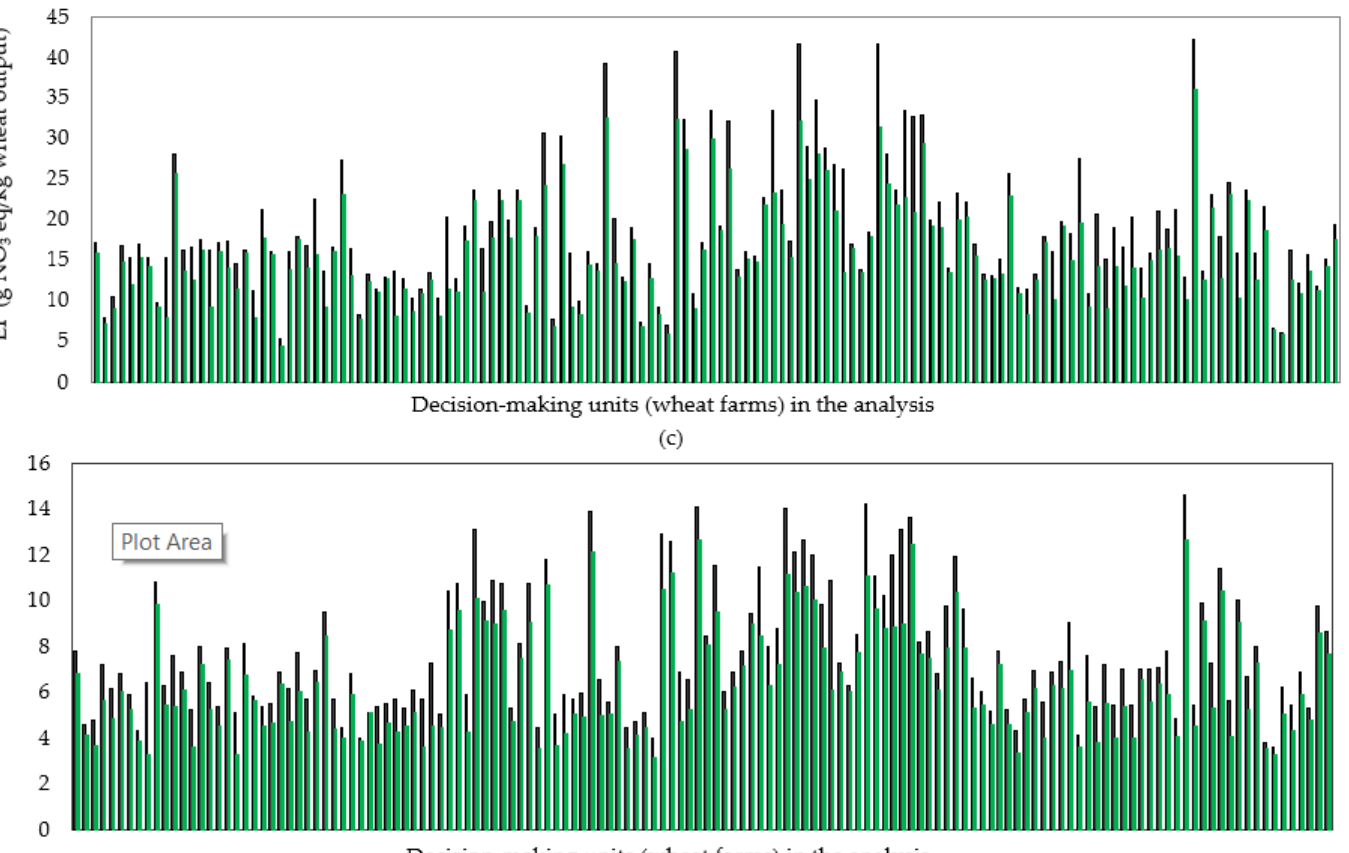
Figure 3. Environmental impact-potentials of inefficient farms and virtual targets for 1 kg wheat production (( a ) GWP: Global Warming Potential, ( b ) AP: Acidification Potential, ( c ) EP: Eutrophication Potential, ( d ) NRE: Non-renewable Energy Use).